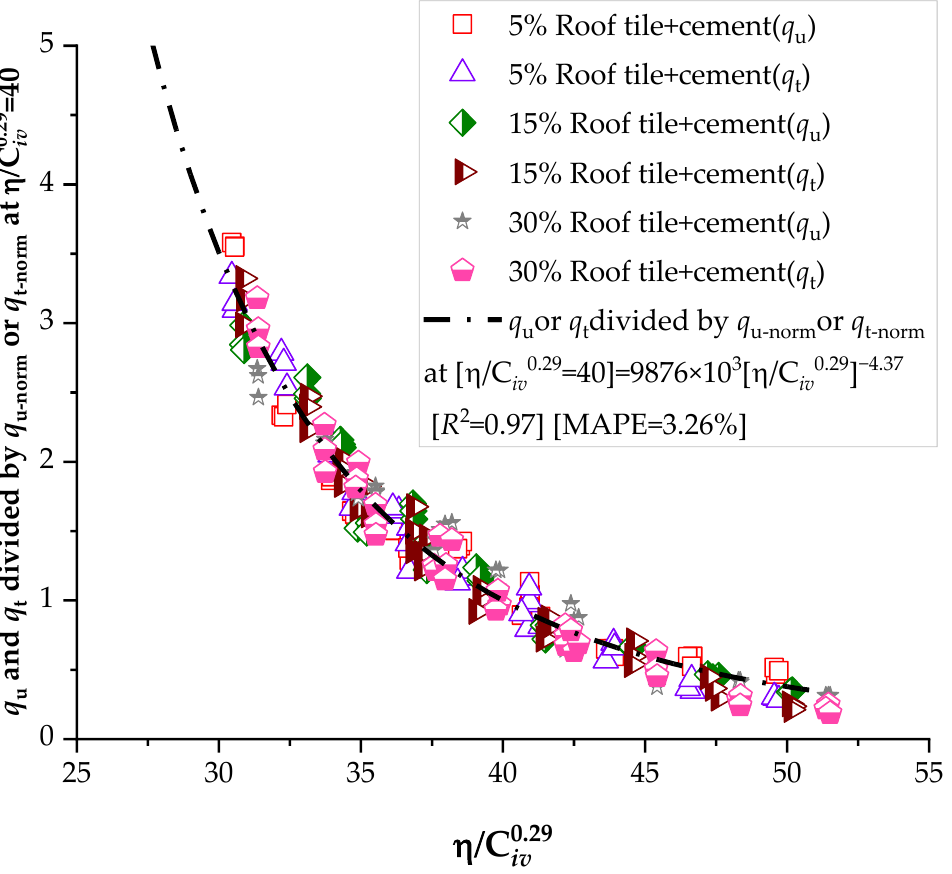
Figure 8. Normalization of the unconfined compressive and split tensile strength (for the whole range of η /C iv 0.29 ) by dividing for q u and q t at porosity/cement index equal to 40%, considering the strength of the cement-treated silty soil-roof tile waste mixtures .